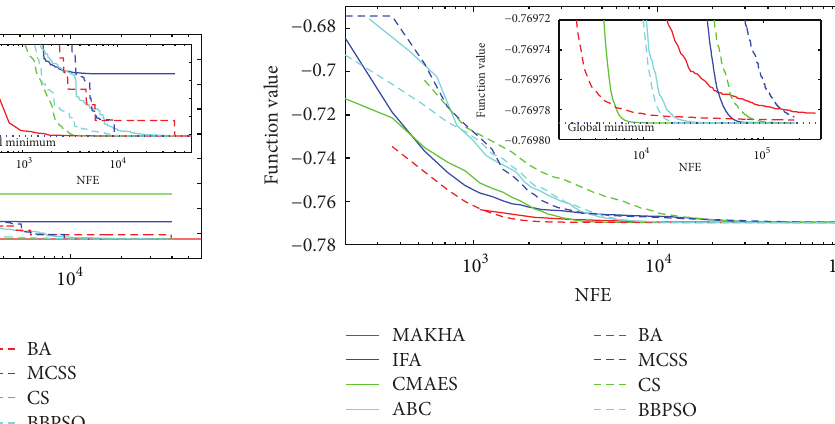
Figure 4: The evolution of the mean best value calculated via the eight metaheuristics versus NFE for problem G4.